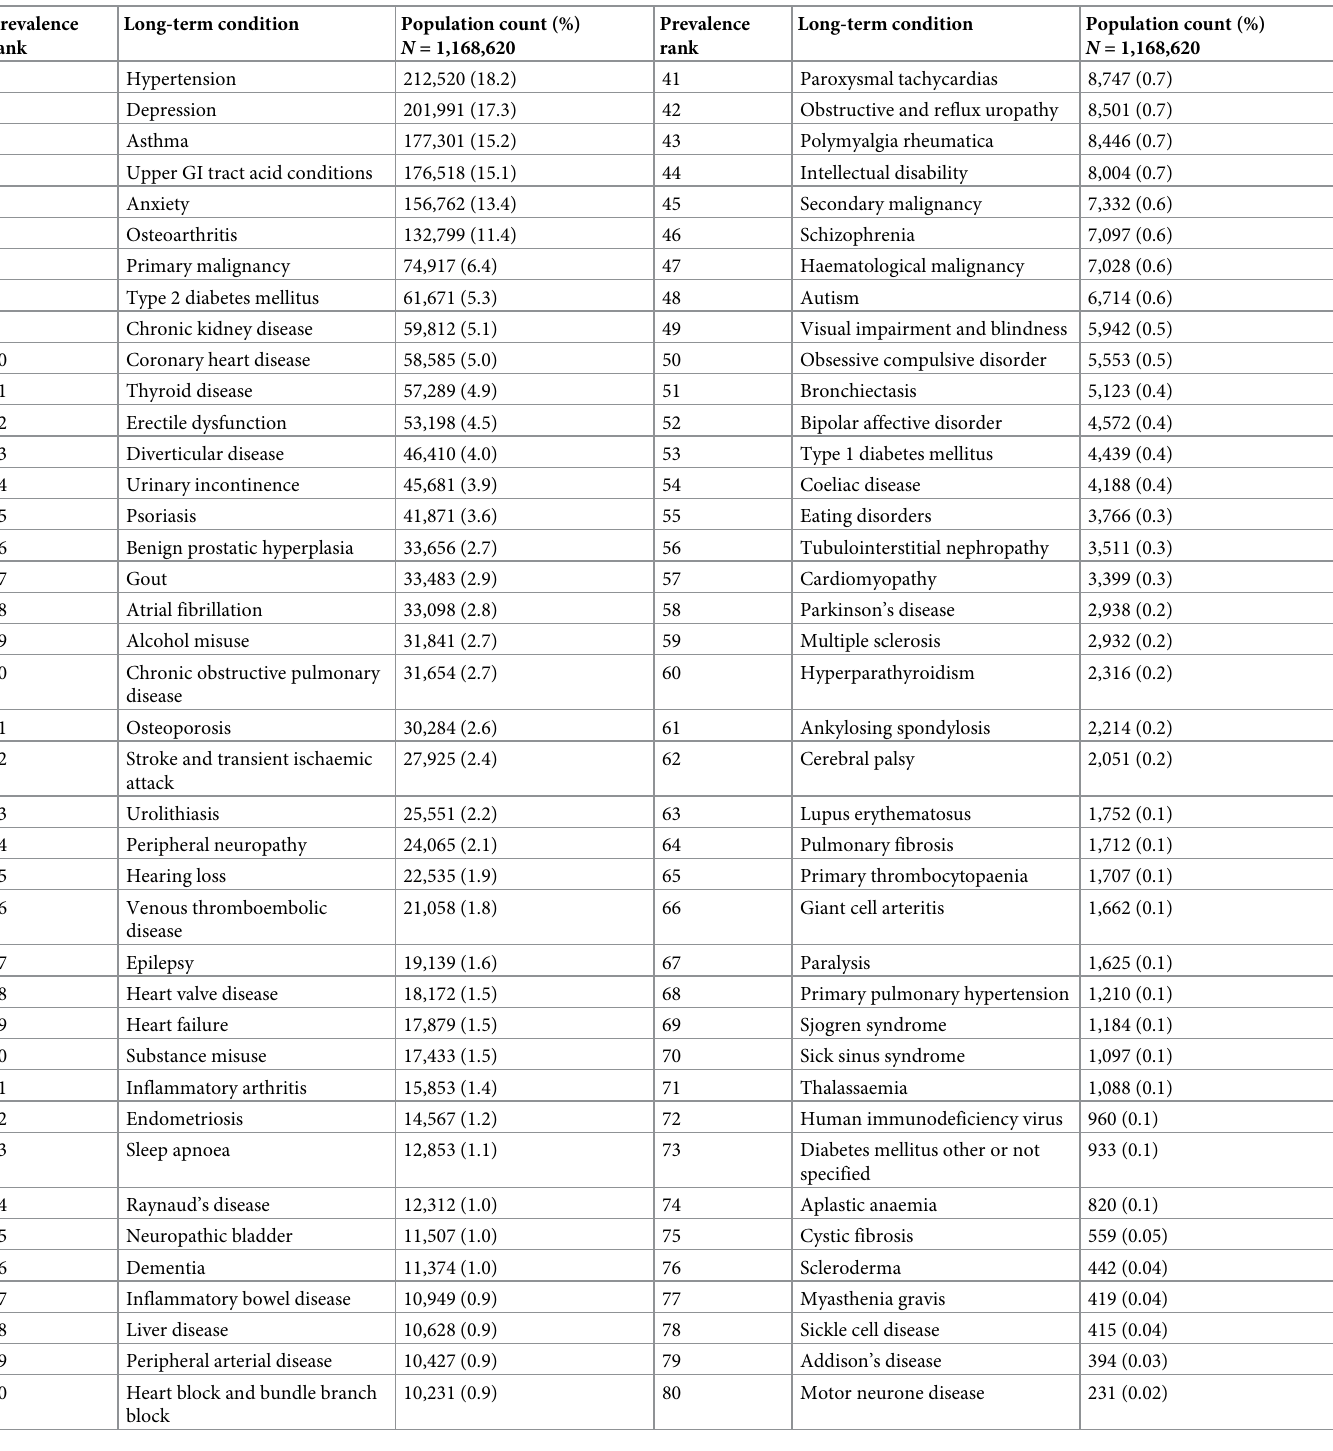
Table 2. Prevalence of individual